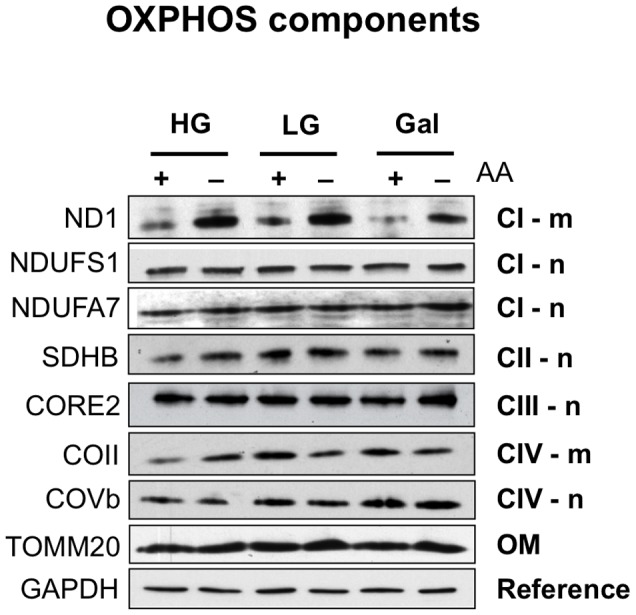
Amino acid starvation does not induce mitochondrial biogenesis.After growing HEK cells for 72: Respiratory complex I subunits, ND1, NDUSF1, and NDUFA7; complex II, succinate dehydrogenase subunit B; complex III, CORE2; complex IV, COVb and COII. TOM20, outer membrane protein of mitochondria (OM); GAPDH, reference protein. m, protein product of mtDNA; n, product of nuclear DNA.